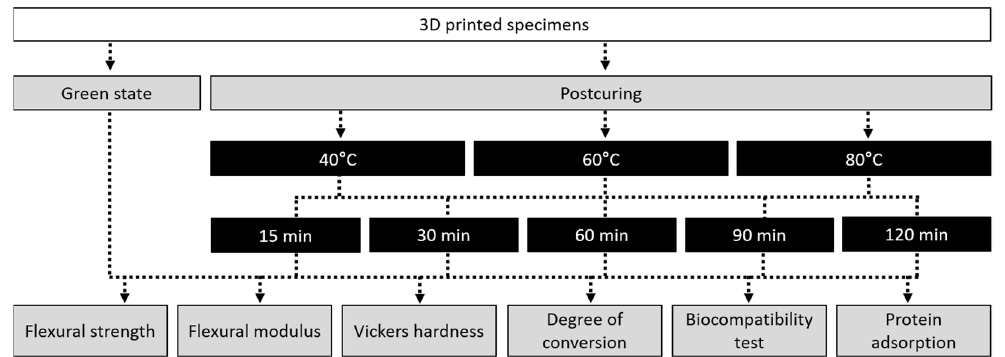
Figure 1. Workflow of the overall experimental process, showing the postcuring conditions and types of experiment.